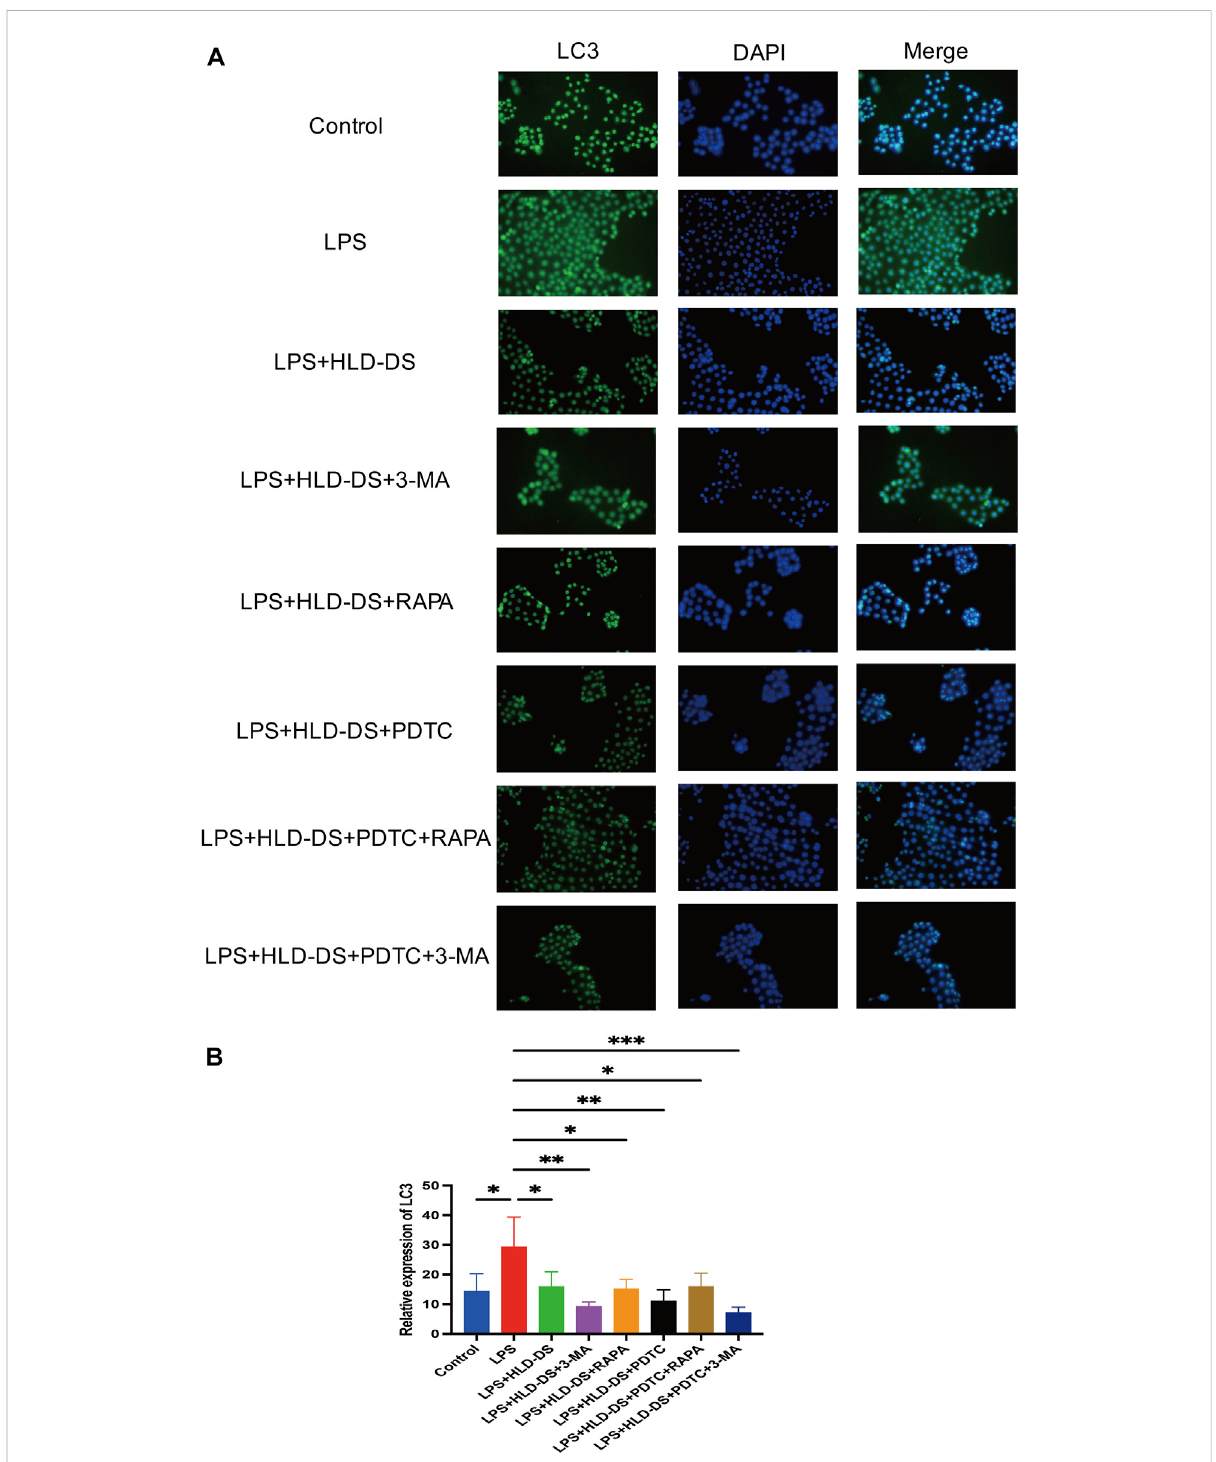
FIGURE 8 HLD-DS inhibited expression of LC3 in cells detected by immuno fl uorescence. (A) LC3 expression was detected by immuno fl uorescence in LPS-induced NCM-460 cells. (B) Quantitative results of LC3 protein expression in LPS-induced NCM460 cells. All data are expressed as the mean ± SD. ( n = 3). * p < 0.05, ** p < 0.01, *** p <